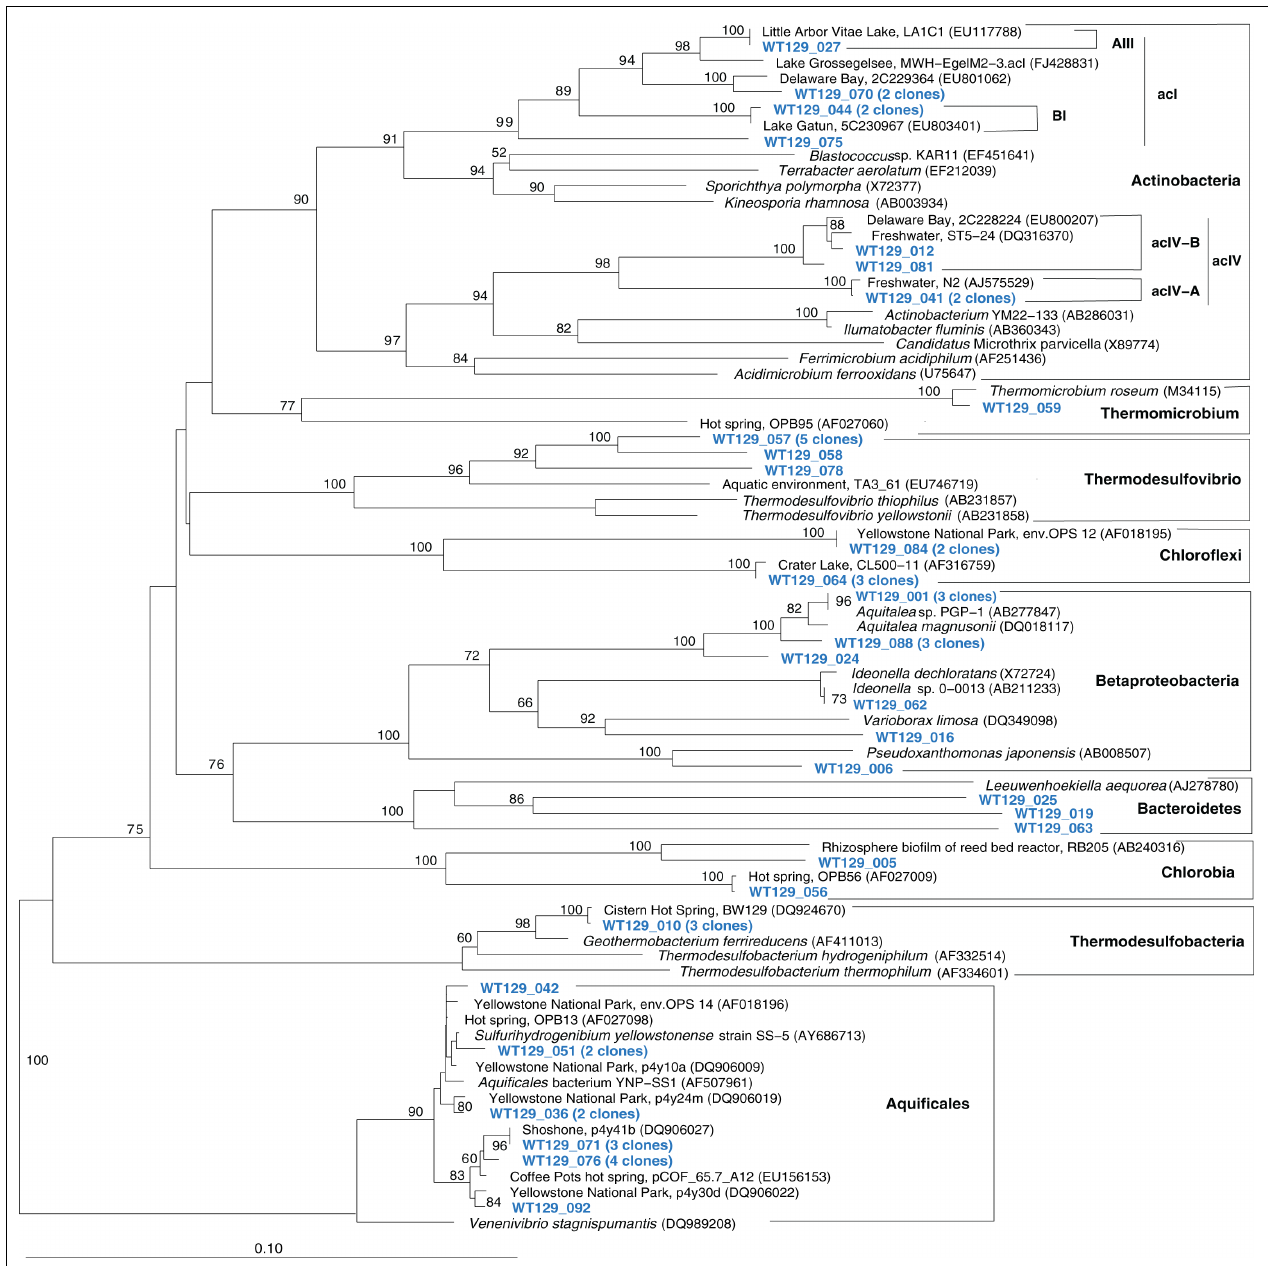
FIGURE 6 | Phylogeny ofWestThumb Canyon 129 bacterial clones, based on E. coli gene nucleotide positions 25–573.